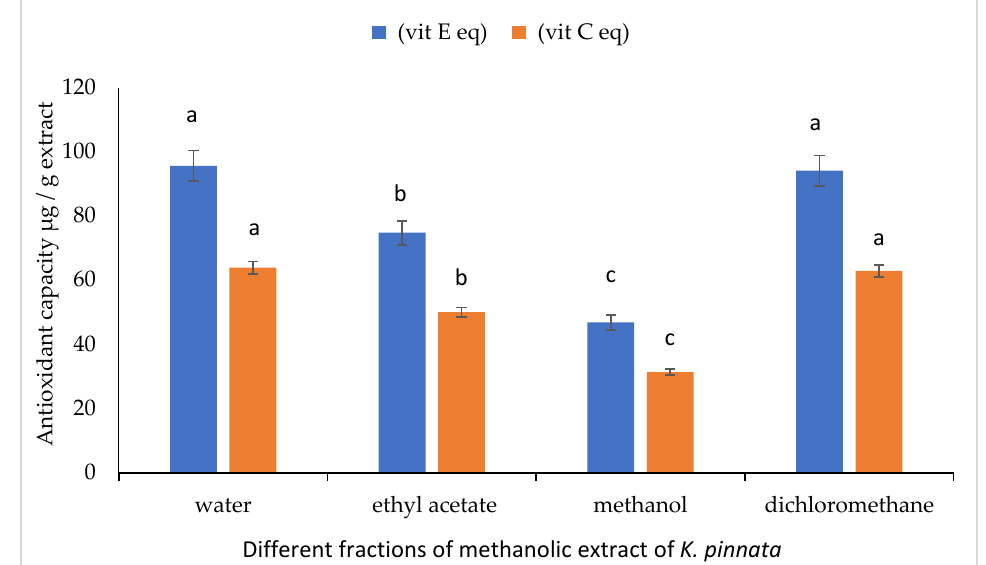
Figure 5. Antioxidant capacity of different fractions (water, ethyl acetate, methanol and dichloromethane) of mature (K m ) fruits of K. pinnata . The values are the means of three replicates with standard deviation ( ± SD). Duncan’s multiple tests ( p ≤ 0.05) found no statistically significant differences between the values in each bar with the same letter. Vit E eq (vitamin E equivalent) and vit C eq (vitamin C equivalent). Table 5. DPPH-scavenging activity of different fractions (water, ethyl acetate, methanol, and dichloromethane) of mature (K m ) fruits of K. pinnata . Range Extract